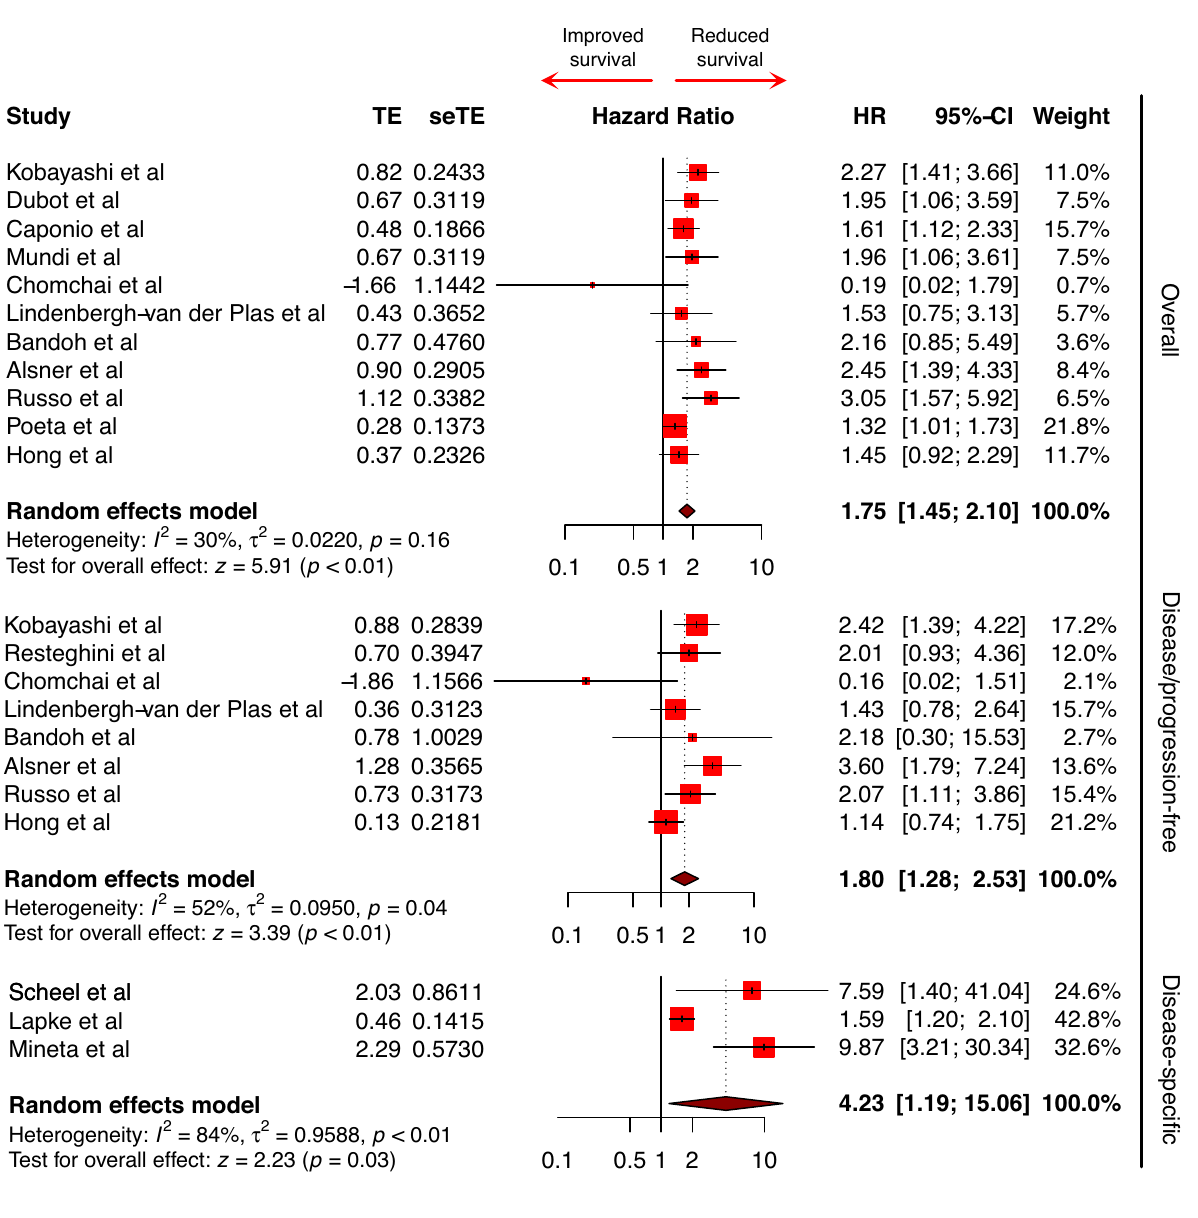
Figure 3. Forest plot graphically representing the meta-analysis on the association between TP53 mutation and survival (overall, disease/progression-free, and disease specific). HR was used as effect size